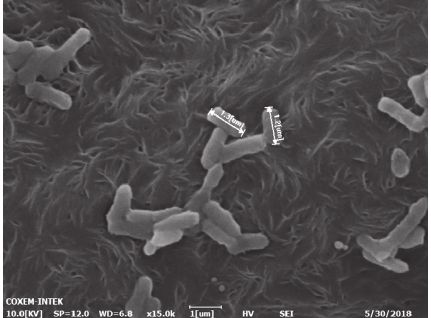
Figure 11: S. braenderup without presence of AgNPs (control). Morphology as assessed by